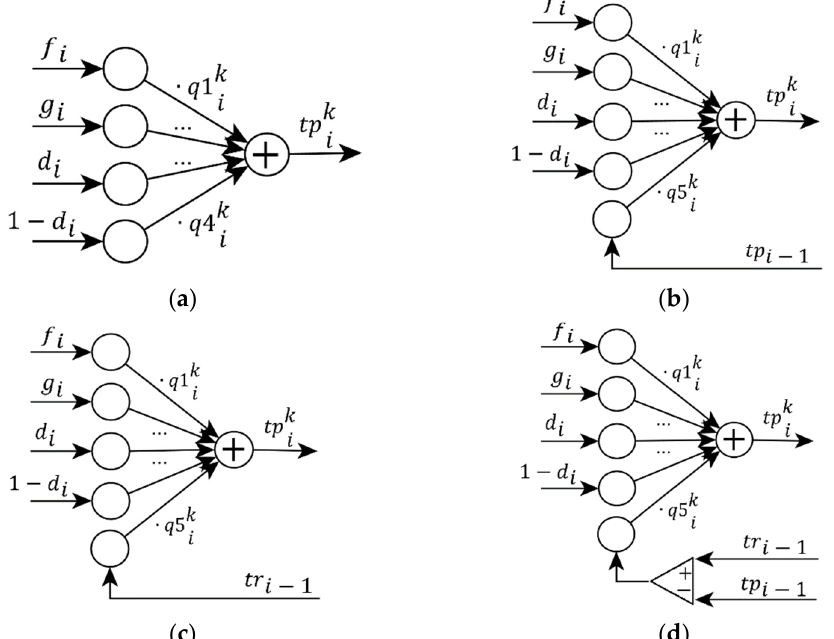
Figure 10. Diagrams of modified neural networks: ( a ) before modification—four inputs; ( b ) on the fifth input—the estimated time of the last request; ( c ) on the fifth input—the time of the last request; ( d ) on the fifth input—the difference between the response time of the last request and its estimated value.